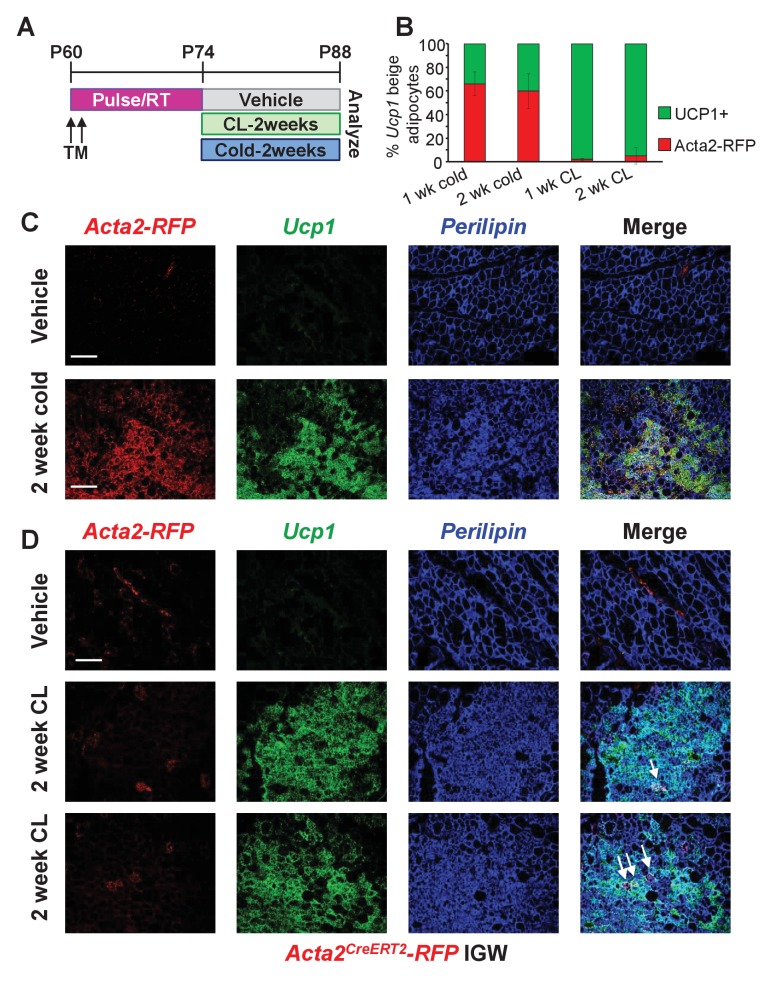
Acta2+ smooth muscle cells are a source for cold induced beiging but not for Adrb3.(A) Experimental procedure to TM induce two-month-old Acta2Cre-ERT2; RosaR26RFP; (Acta2-RFP) male mice which were subsequently cold exposed or CL treated for 2 weeks (n = 5/group). (B) Graphical representation of Acta2-RFP fate mapping studies in response to cold exposure and CL treatments. Representative IHC images from mice described in (A) were quantified for Acta2-RFP and Ucp1 co-localization (n= 4 mice/group). (C) Representative IHC staining of IGW depot sections from cold mice described in (A). (D) Representative IHC staining of IGW depot sections from CL mice described in (A). Two representative IHC staining of IGW depots of CL-treated mice were shown to demonstrate variability throughout the tissue. All data are means ±SEM. Scale bar = 200 µm.